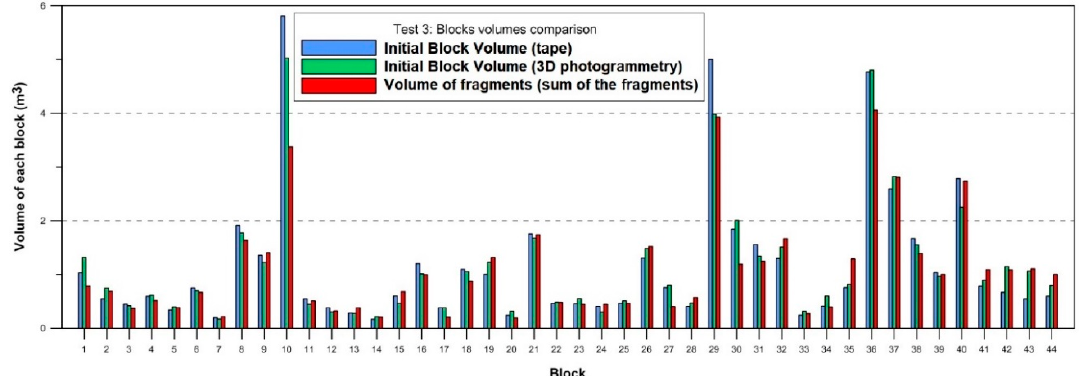
Figure 8. Initial block volume measured with a tape, initial block volume from 3D models and sum of the generated fragments’ volume, in test 3.